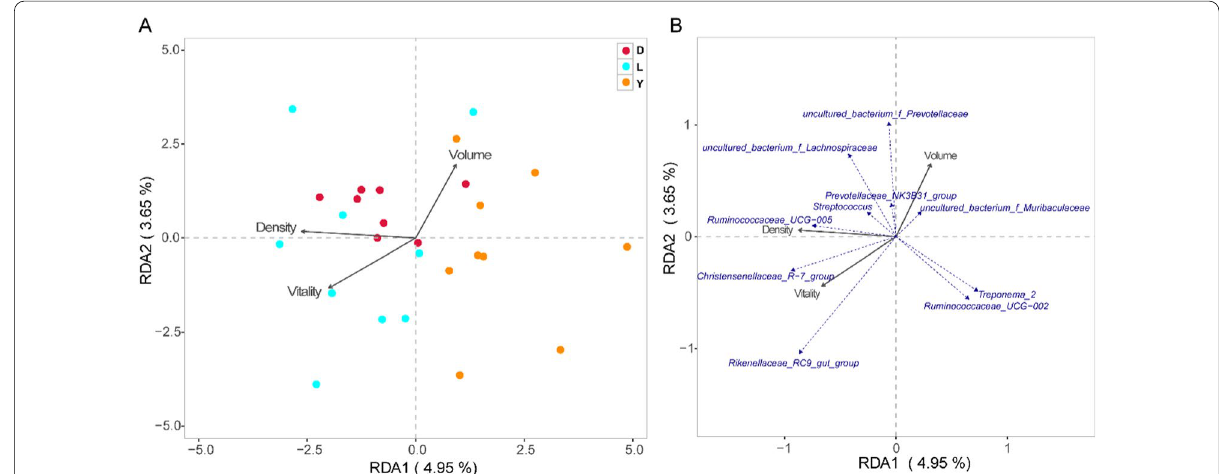
Fig. 3 A Correlation analysis between three varieties and environmental factors; B Correlation analysis between the top ten species of genus level abundance andenvironmental factors. Thescale on the horizontal and vertical coordinates are the values generated byeach sample or species in the regression analysis calculation withenvironmental factors; points represent samples; the relationship betweenelement points and points in the figure is represented by distance, the closerthe distance is, the sample is represented composition is similar; therelationship between rays and rays is represented by an included angle. Anobtuse angle indicates a negative correlation between the two physiologicalindicators, and an acute angle represents a positive correlation. The smallerthe angle, the higher the correlation. The longer the arrow, the greater theinfluence on the sample distribution, and the gray arrows represent differentenvironmental